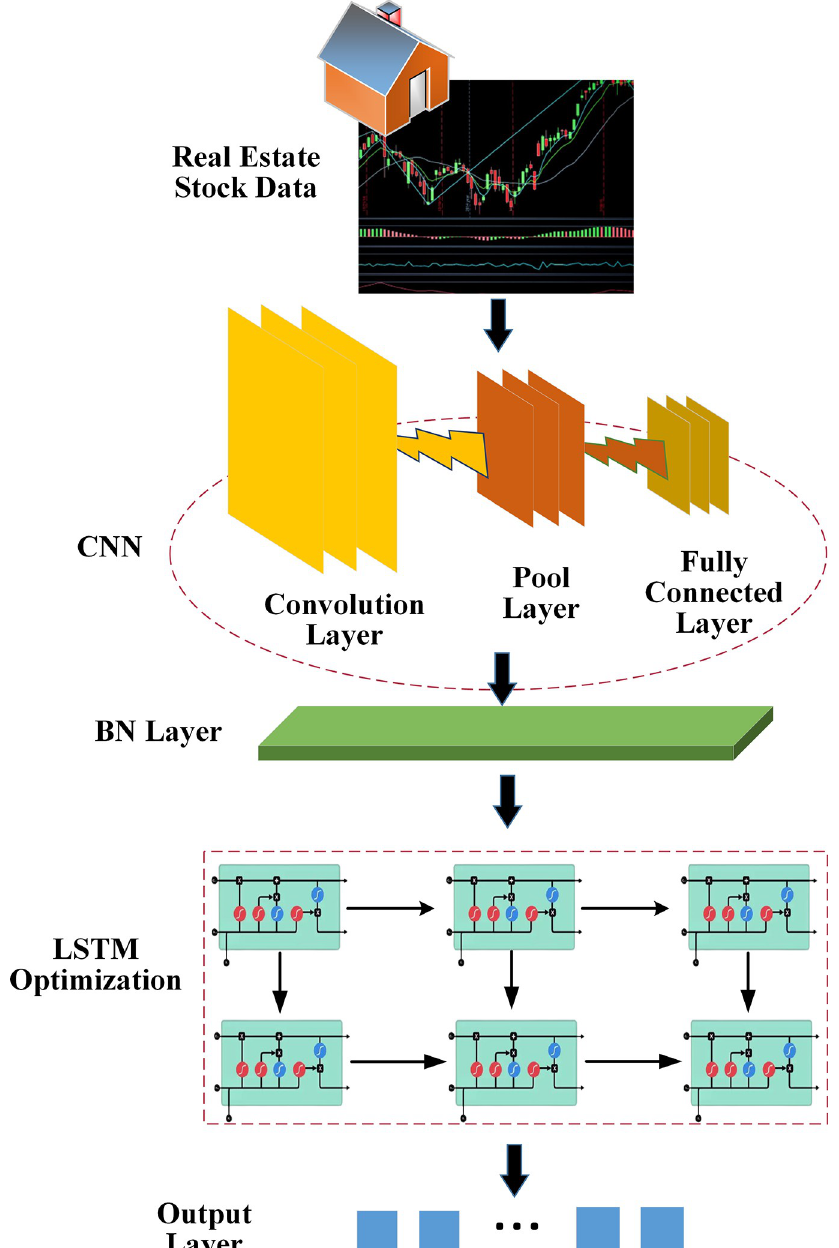
Fig 5. The prediction model framework of real estate index and stock trend based on CNN-LSTM algorithm optimized by DL.